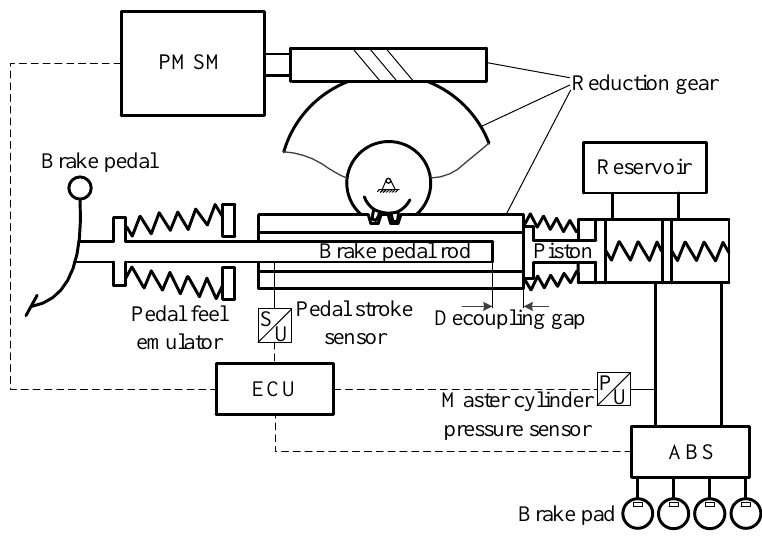
Figure 4. Scheme of the EHB [24].